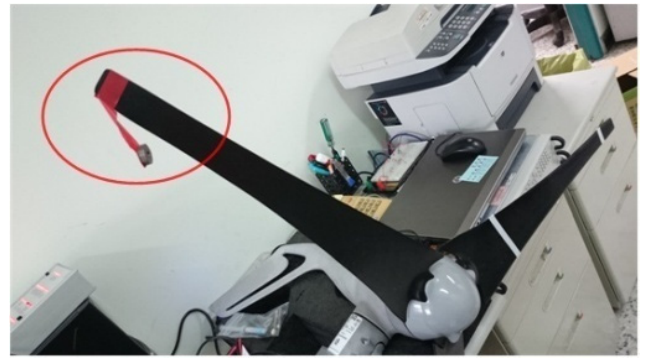
Figure 25. A blade with a hanging